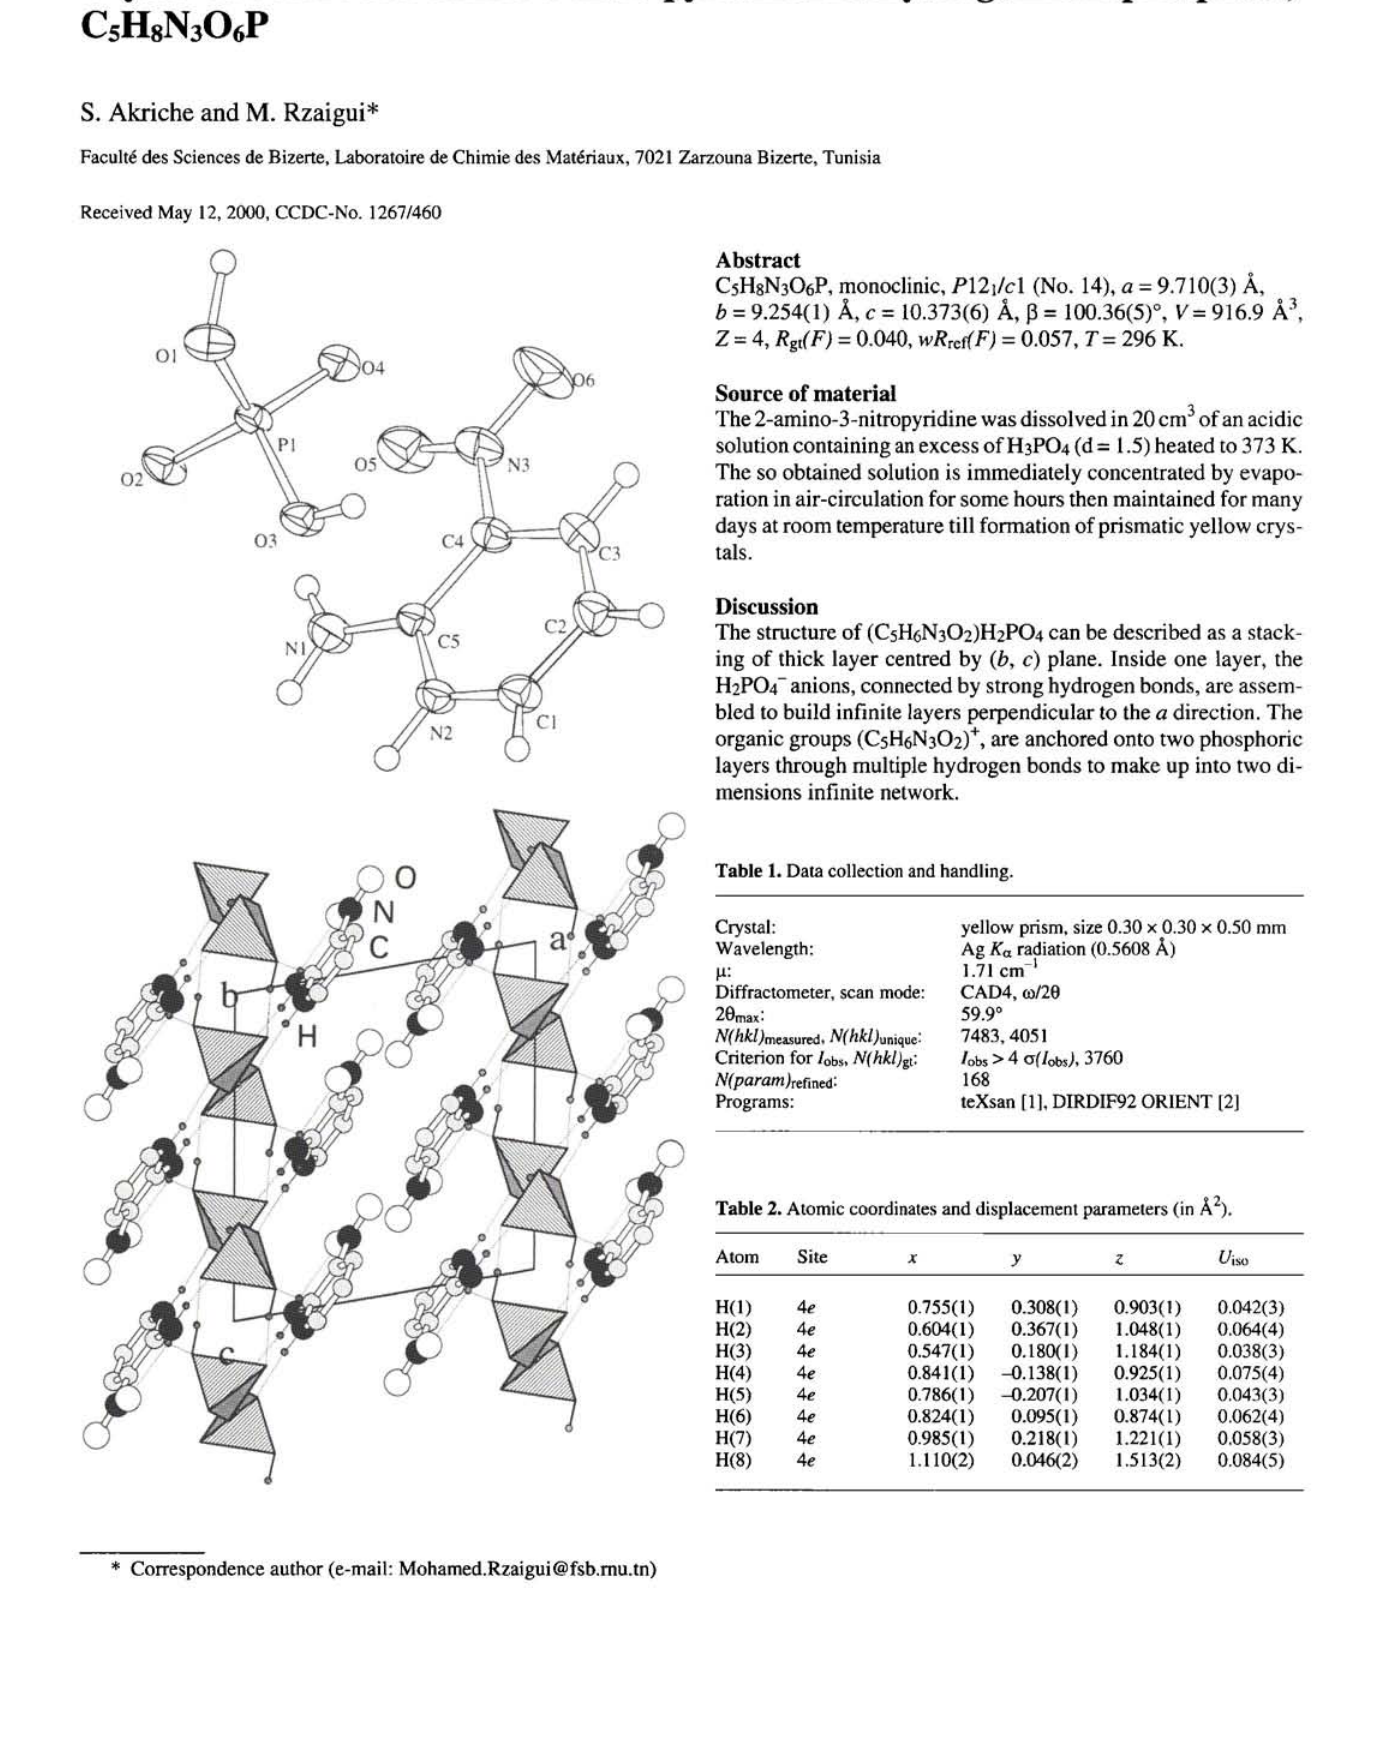
Table 2. Atomic coordinates and displacement parameters (in Â 2